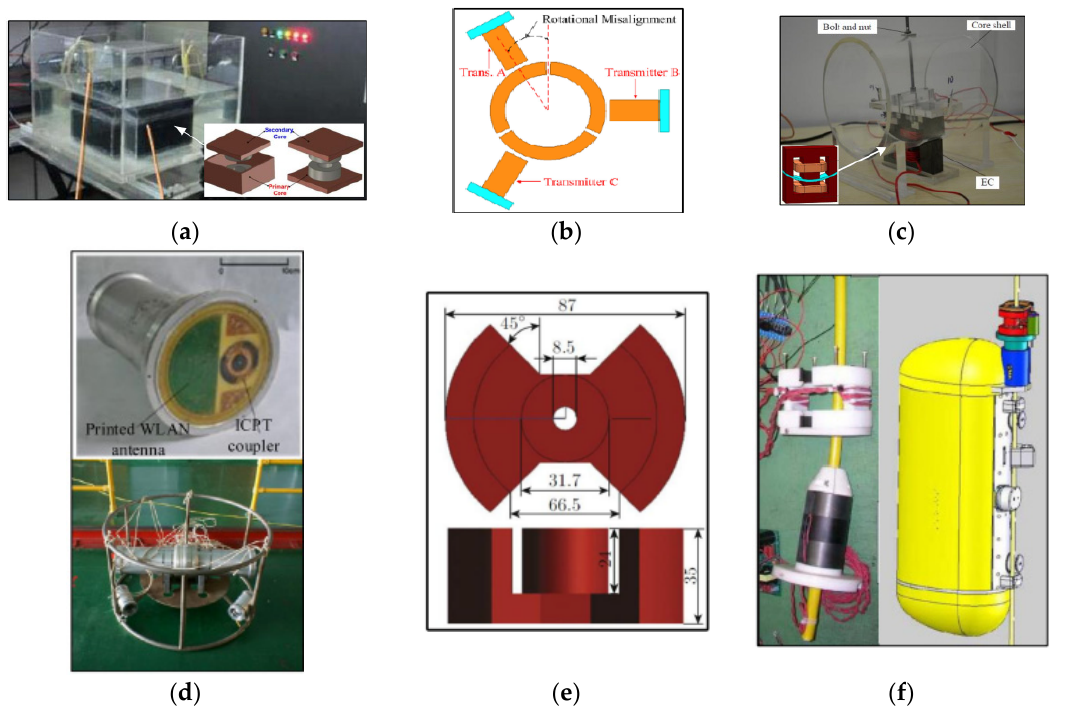
Figure 16. Different magnetic and inductive couplers proposed by: ( a ) Cheng et al. [68]; ( b ) Kan et al. [81]; ( c ) Yan et al. [81]; ( d ) Zhou et al. [84]; ( e ) Wang et al. [87] and ( f ) McGinnis et al. [77]. Table 6. Comparison between different couplers for UWPT.